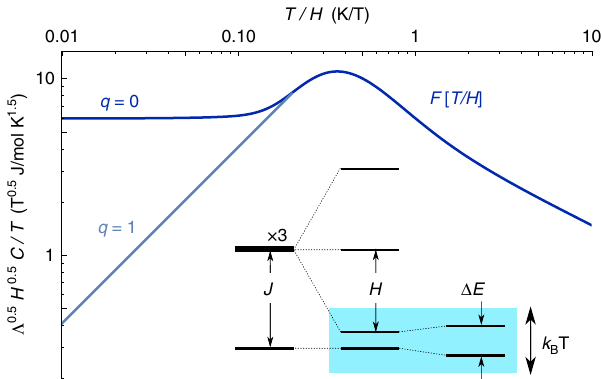
Fig. 1 Heat capacity scaling function F 0 [ T / H ] and its q = 1, 2 modi fi cation by level repulsion. The heat capacity C [ H , T ] for q = 0 random singlets R P ½ E (cid:4) ¼ ð E = Λ Þ 1 (cid:3) γ at γ = 0.5, (shown with integrated energy distribution blue) exhibits scaling collapse in T / H with T -linear form at T (cid:1) H . This is easily understood (bottom inset). A spin – 1/2 pair with singlet-triplet splitting J acquires a resonance in magnetic fi elds H ≈ J , contributing to C [ H , T ] when | J − H | < k T . The scaling is modi fi ed when spin-orbit coupling and B lattice symmetries combine into DM interactions with singlet-triplet mixing: the resulting level repulsion changes the resonance condition Δ E < k B T to produce T -scaling with higher powers, as in the q = 1 line shown